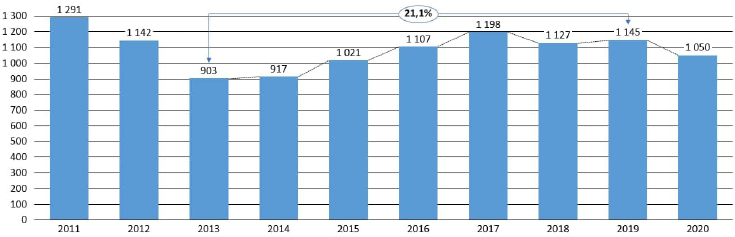
Figure 19. The sown area of sugar beet in the Russian Federation—a thousand hectares.